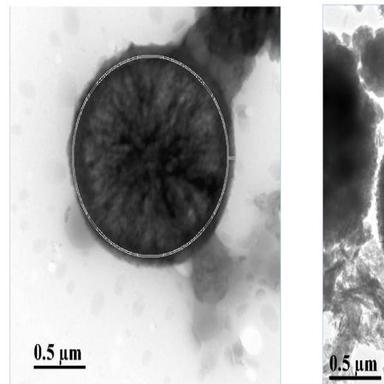
Thickness of PVP in ratio of (a) 10: 1 and (b) 20: 1.